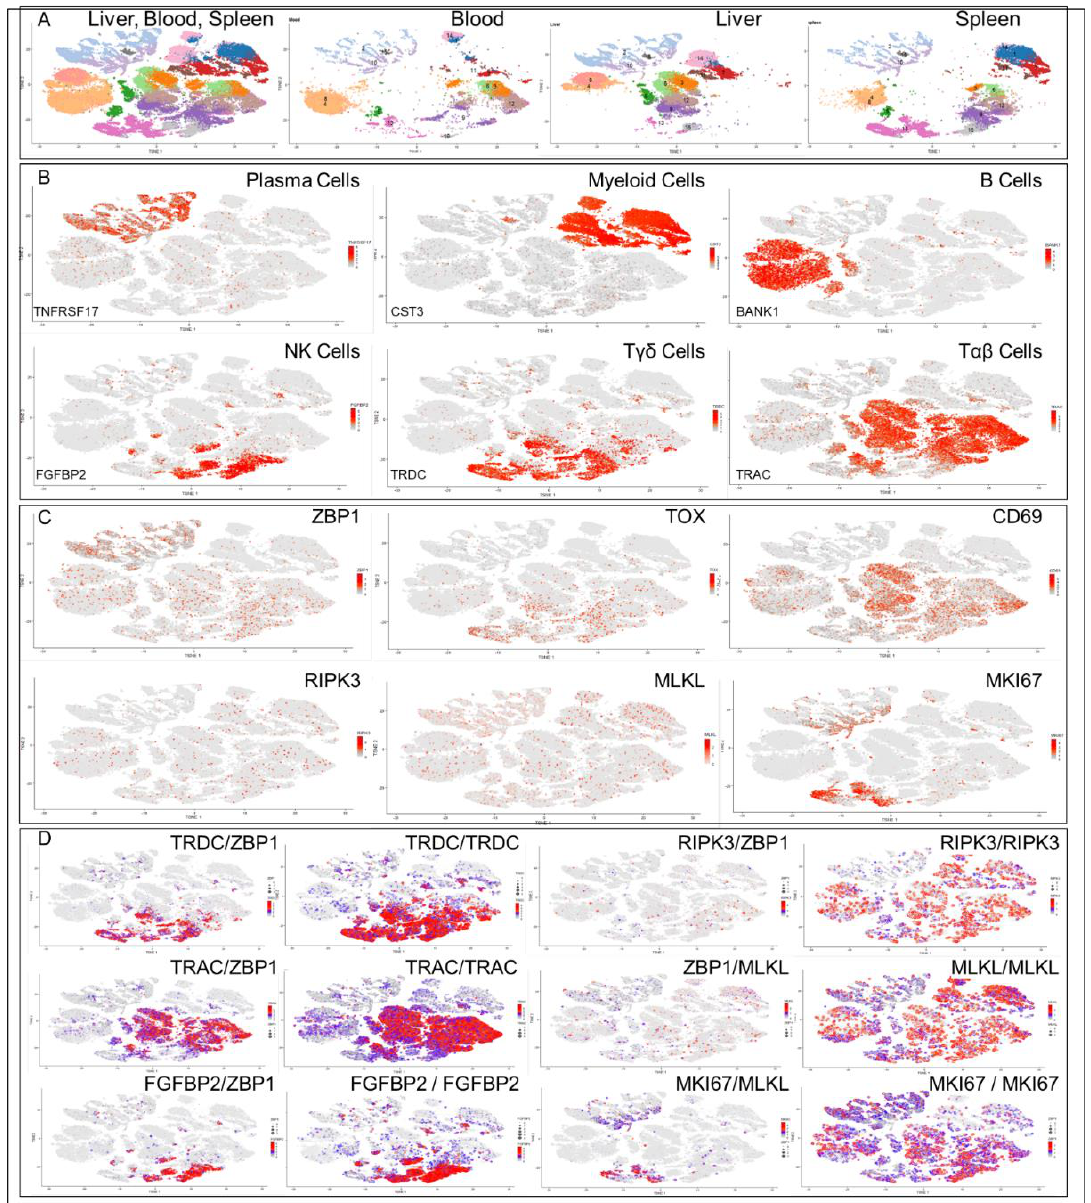
Figure 2. Single cell analysis of RNA expression in human liver, spleen and blood [23] using the UMAP algorithm implemented in the R-package scater [25] (random seed = 1000). ( A ). Clusters by cell type. ( B ) Markers used to assign cell type are listed in the lower left-hand corner ( C ). Expression of genes relevant to ZBP1 induced necroptosis (ZBP1, RIPK3, MLKL), development (TOX, thymo- cyte selection associated high mobility group box), proliferation (MKI67, marker of proliferation Ki- 67) and tissue residence (CD69). ( D ). Coexpression of RNAs. The expression level of one gene is indicated by color and that of the other by size. The left panel of each pair is based on two different genes allowing visualization of how often the two genes are coexpressed. The right panel is based on both the size and color of a single gene, giving the maximum coexpression that is possible. (TRAC, T-cell receptor alpha constant region; TRDC, T-cell receptor delta constant region; FGFBP2,